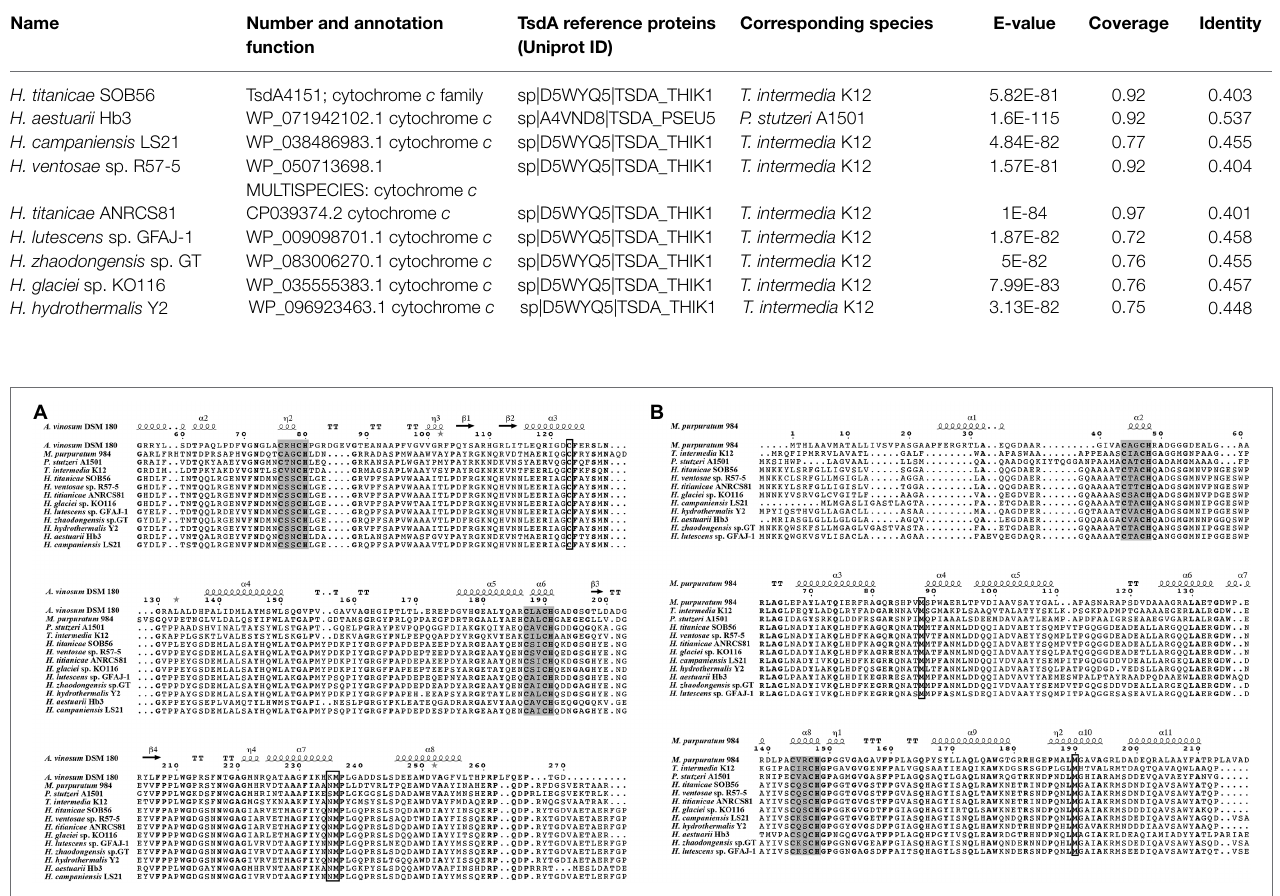
FIGURE 3 | Multiple sequence alignment of the TsdA (A) and TsdB (B) in Halomonas titanicae SOB56 and related organisms. Protein secondary structures were shown on the top of sequences. Referred crystal structures of TsdA and TsdB were from Allochromatium vinosum 180 (PDB code: 4WQ7) and Marichromatium purpuratum 984 (PDB code: 5LO9), respectively. Heme-binding motifs are indicated by gray boxes, and putative distal heme ligands are marked by black squares. Strictly conserved residues are marked with bold font in sequences.